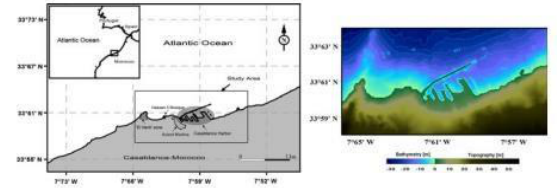
Figure 1. The study area of Casablanca-Morocco, The Bathymetry and topography for the Casablanca and its surrounding